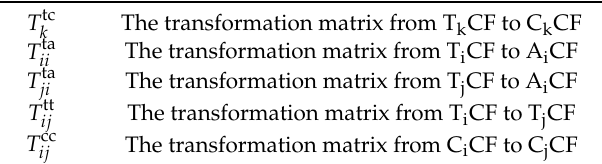
Table 1. Definition of the transformation matrices. T tc